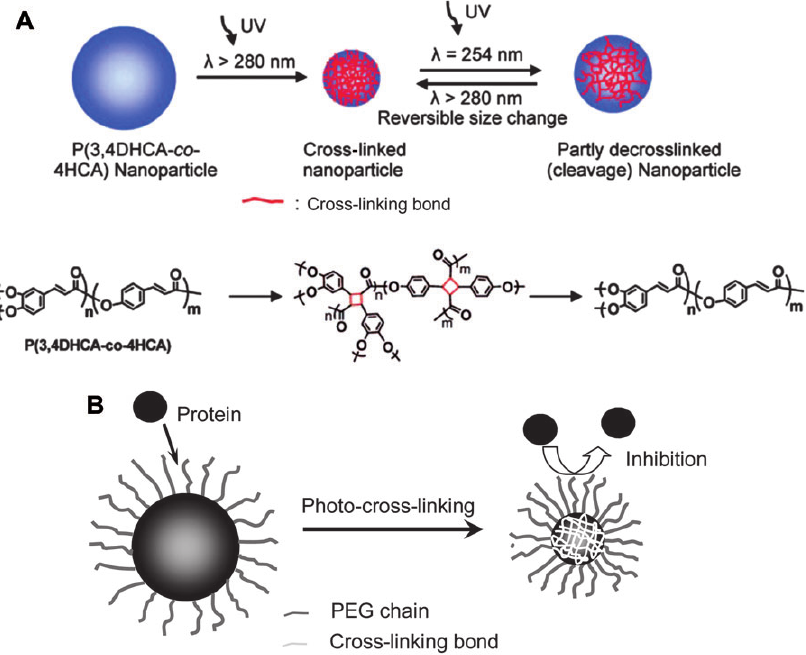
Figure 15 (A) Schematic representation of size change behavior of P(3,4DHCA-co-4HCA) nanoparticles with UV irradiation; chemical structure of UV-induced [2 + 2] cycloaddition formation (cross-linking) and deformation (cleavage) [94] . Reprinted with permission from Ref. [94] . Copyright (2008) American Chemical Society. (B) Schematic illustration of protein adsorption onto the nanoparticle surface before and after photo cross-linking of the cinnamate groups with UV irradiation at λ > 280 nm [95] . Reprinted with permission from Ref. [95] . Copyright (2009) American Chemical